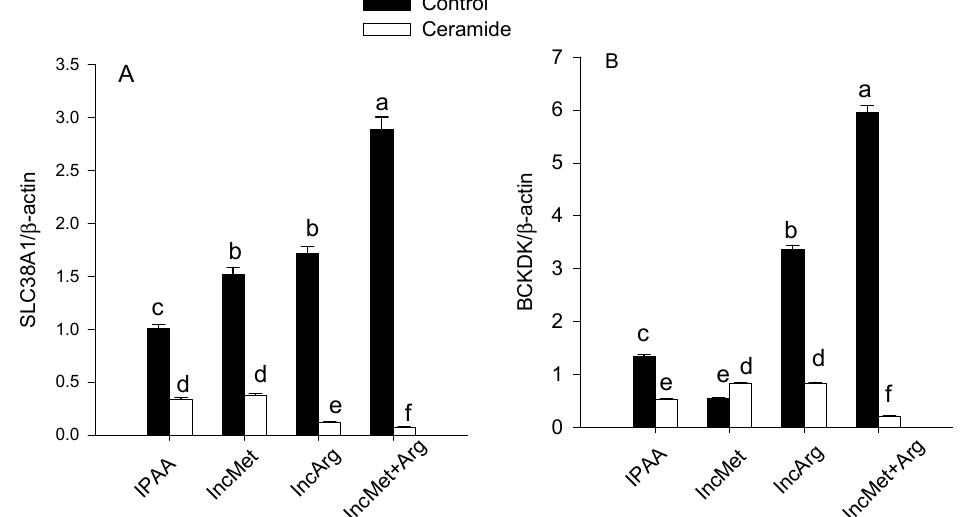
Figure 3. Protein abundance (relative to β -actin) of SLC38A1 (panel A ) and BCKDK (panel B )